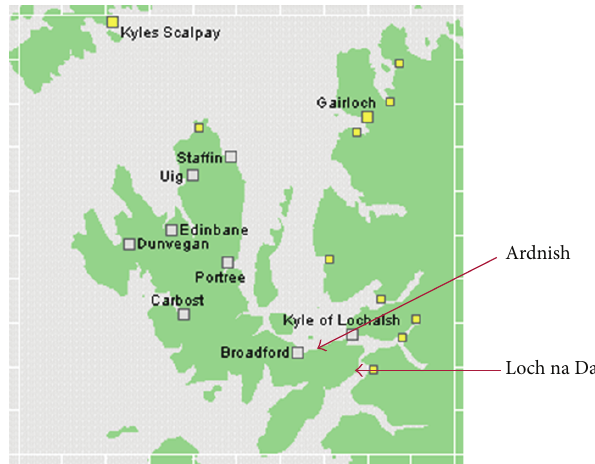
Figure 1: Coastal sections used on the Isle of Skye,